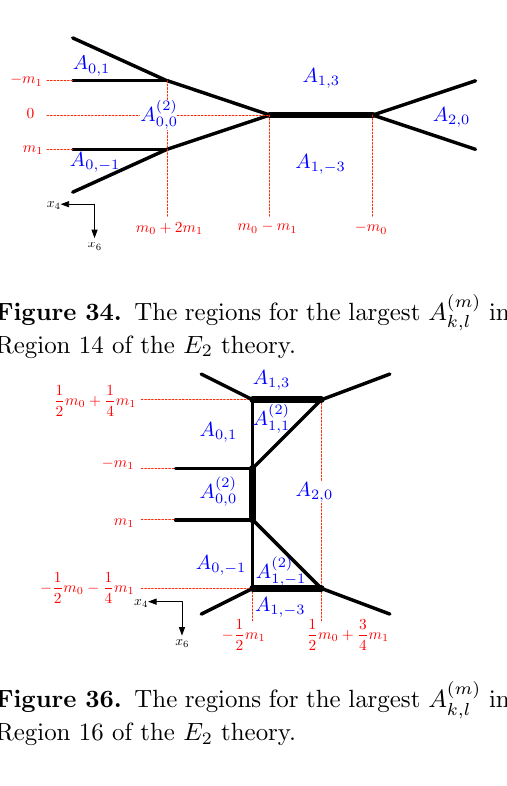
in Figure 32. The regions for the largest A ( m ) k;l Region 12 of the E 2 theory.